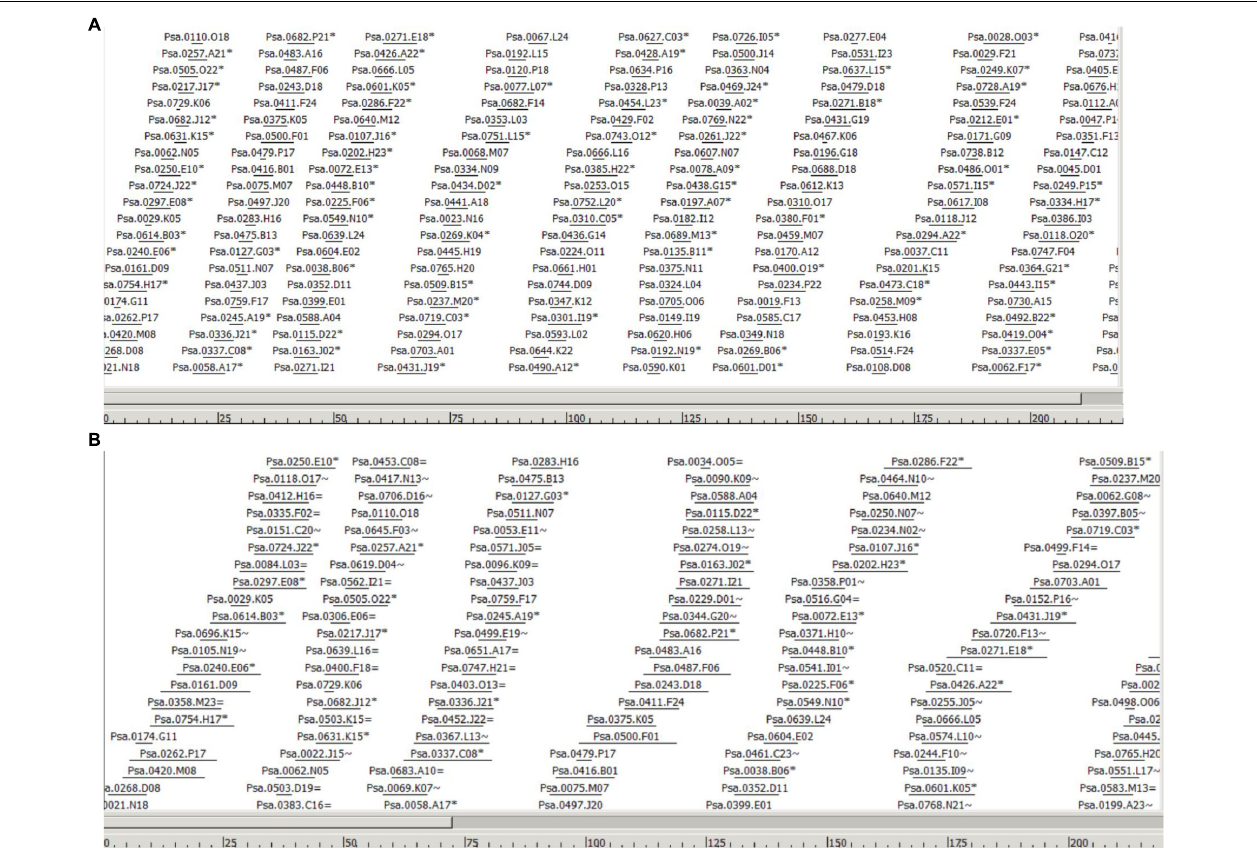
FIGURE 1 | Part of the largest contig in the assembly (Ctg 2178) based on number of BACs and tags. The BACs are ordered to their position in the contig. Horizontal lines indicate relative BAC length and positioning of the lines indicates relative position and degree of overlap between BACs. The scale at the bottom represents the consensus band (CB) scale units. (A) Only non-buried BACs are shown, i.e., a semi-minimal tiling path, meaning that BACs which overlap largely with another BAC in the contig are not displayed. BACs indicated with a ∗ indicate the presence of one or more buried BACs at this position. (B) Part of the same contig in the assembly showing all the buried BACs. Buried BACs are marked with = or ∼ , where = means identical and ∼ means nearly identical. The figures are in CB units; the length of the entire contig is 1532 CB units.